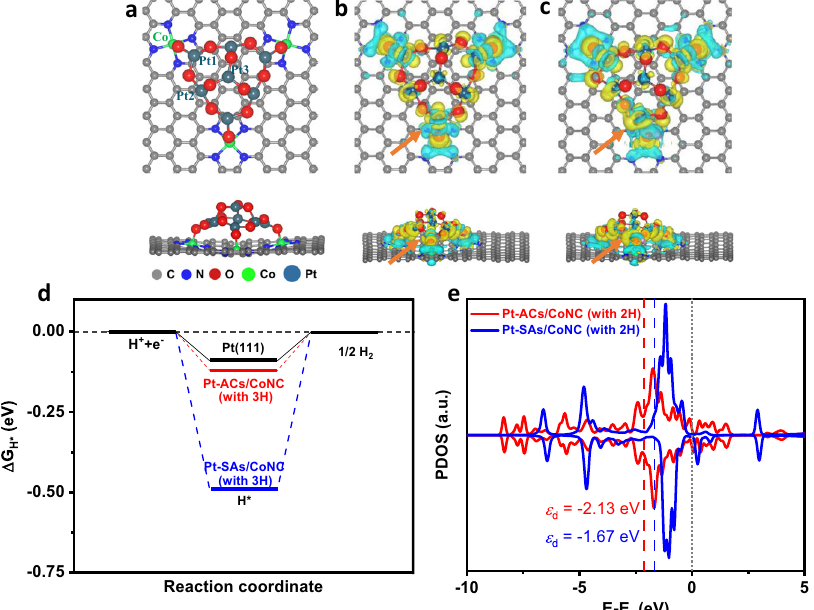
Fig. 4 DFT calculation results. a The top and side view of the atomic structure of Pt-ACs/CoNC. b the top and side view of deformation electronic density of Pt-ACs/CoNC. The yellow region represents charge accumulation and the blue region indicates charge depletion; the isosurface value is 0.001 e/Bohr 3 . c the top and side view of deformation electronic density of Pt-ACs/CoNC with O bridge occupied with H* (the orange arrow). d The Δ G H (cid:1) of HER at the equilibrium potential for Pt-ACs/CoNC, Pt-SAs/CoNC and commercial Pt/C. e The PDOS of d orbitals of active Pt atoms on Pt-ACs/CoNC and Pt-SAs/ CoNC. The dotted grey line indicates the Fermi level, and the d-band centers ( ɛ d ) are denoted by dashed